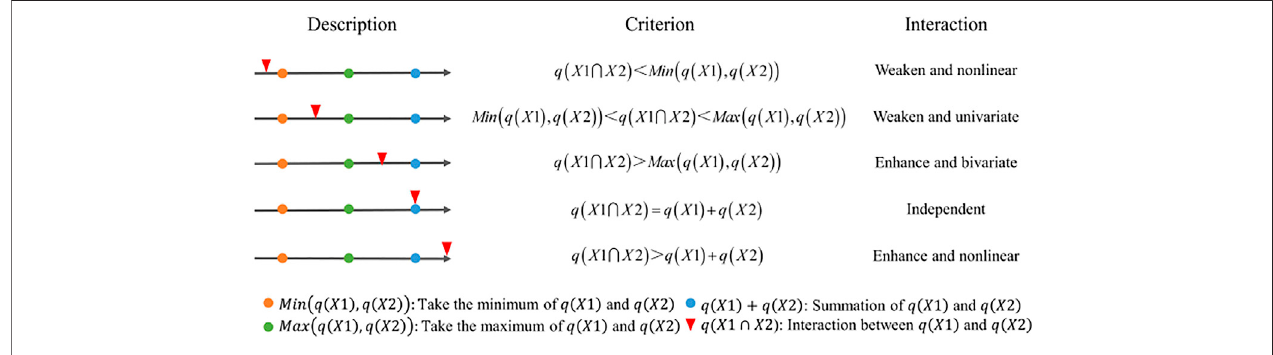
FIGURE 1 | Interaction